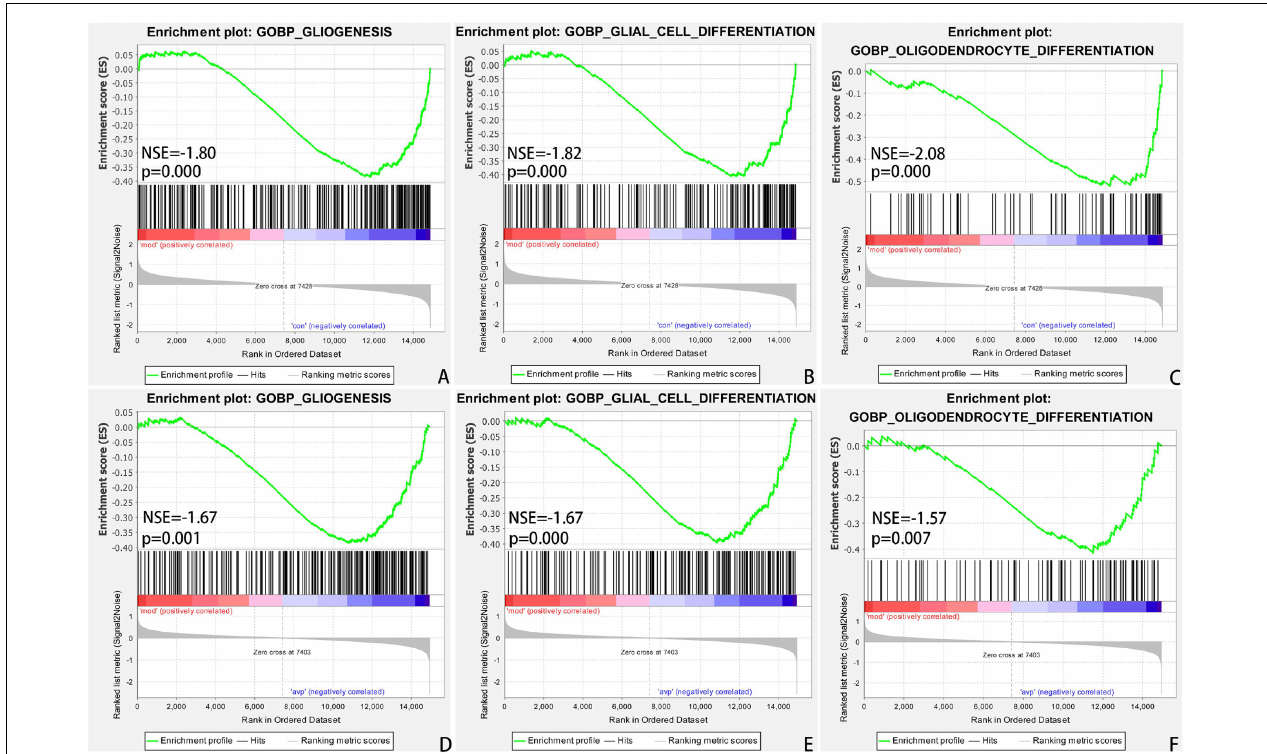
FIGURE 9 | Enrichment of related biological process by GSEA. (A) Gliogenesis in control (con) vs. autism (mod), (B) glial cell differentiation in control (con) vs. autism (mod), (C) oligodendrocyte differentiation in control (con) vs. autism (mod), (D) GLIOGENESIS in AVP vs. autism (mod), (E) glial cell differentiation in AVP vs. autism (mod), and (F) oligodendrocyte differentiation in AVP vs. autism (mod). The significantly enriched gene set was selected with |NES| > 1 and with NOM p < 0.05.